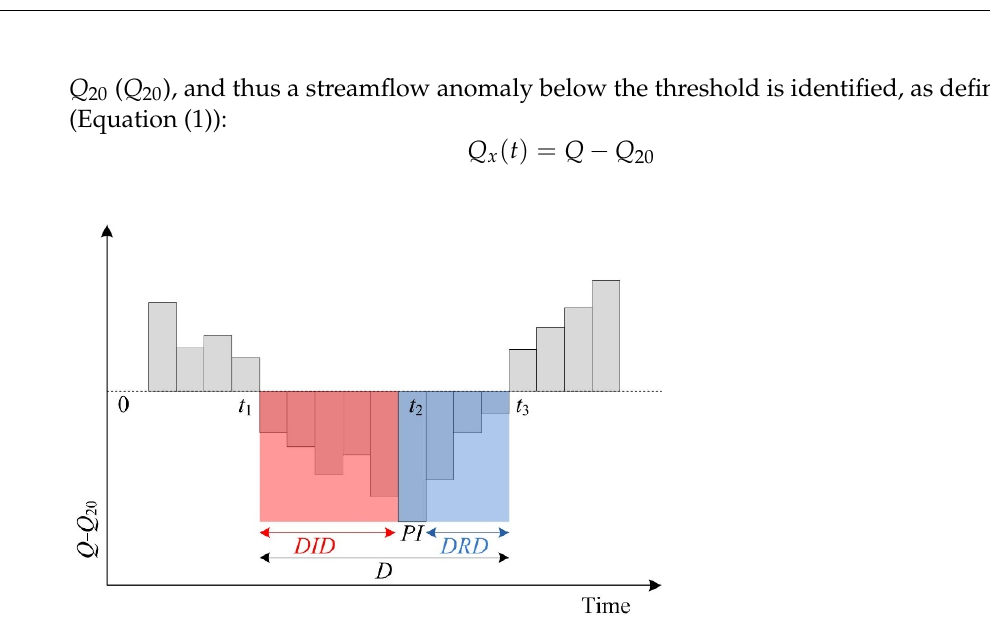
Figure 1. Propagation characteristics of hydrological drought. D is the drought duration; DID and DRD represent drought intensification and recovery durations; and PI is the peak intensity. Red and blue shaded represent intensification and recovery stages of hydrological drought, respectively.